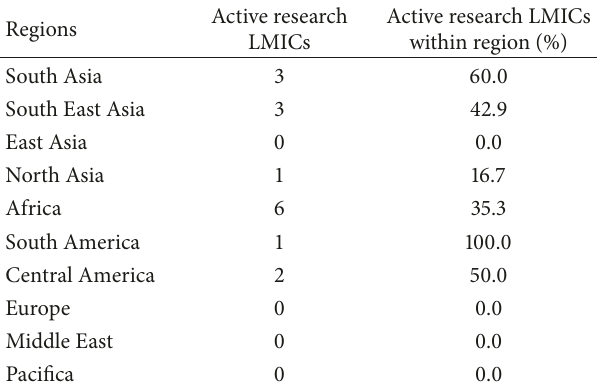
Table 3: The proportion of breast cancer research active LMICs per region . The proportion of LMICs in each region undertaking breast cancer research was calculated to determine the distribution of research within each